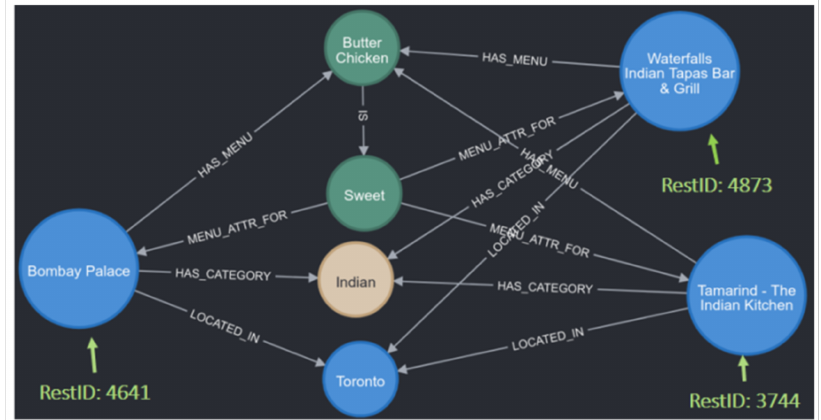
Figure 10. Comparison of Q2B results with native cypher query results for user Query (1).